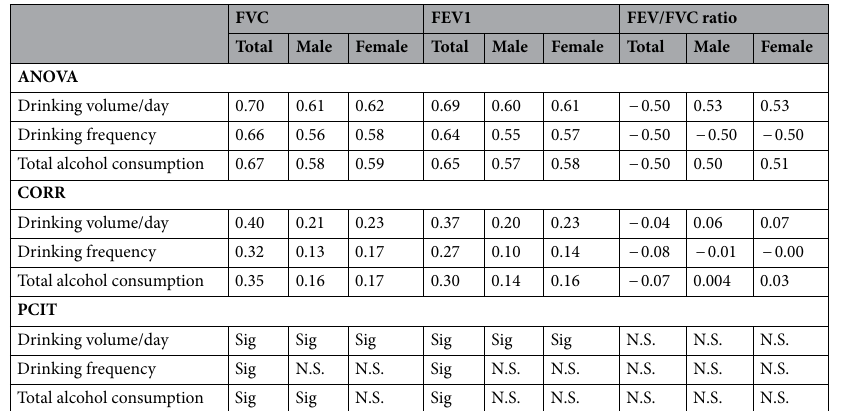
Table 2. An independent positive correlation between drinking habits and lung function calculated by three statistical algorithms. Correlation values between drinking habits and lung function calculated with three statistical algorithms (ANOVA, CORR, and PCIT) using data from subjects who received health checkups at Keio University Hospital in 2018 (n = 6036). Sig significant, N.S. not significant.